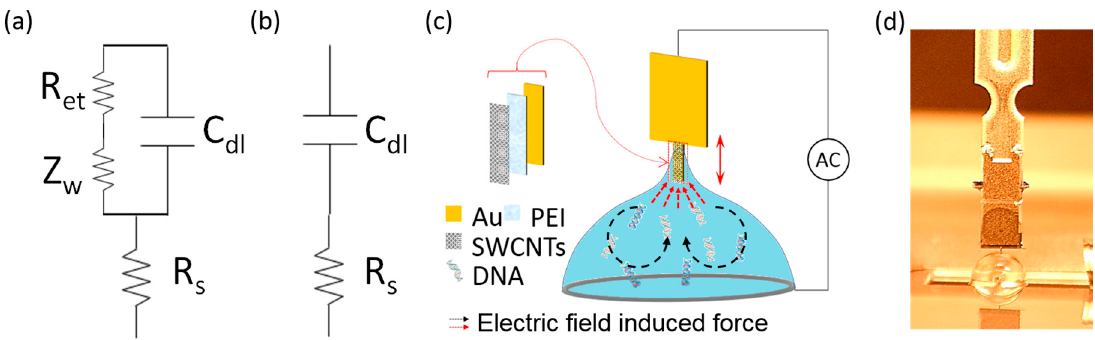
Figure 2. ( a ) General equivalent circuit for electrochemical measurement; ( b ) Equivalent circuit for electrochemical measurement in the absence of the redox probe; ( c ) Working principle of a microneedle: DNA in a sample is concentrated by electrokinetic flow (black arrow). The concentrated DNA is further attracted to the microneedle by dielectrophoresis (red arrow). The attracted DNA is captured on the microneedle surface with capillary action when the microneedle is withdrawn from the solution. The captured DNA is detected in DI water through the electrical measurement; ( d ) Picture of the microneedle immersed in the sample solution: experimental setup composed of the functionalized needle, a solution drop in a well plate, a signal generator, and a picoammeter.